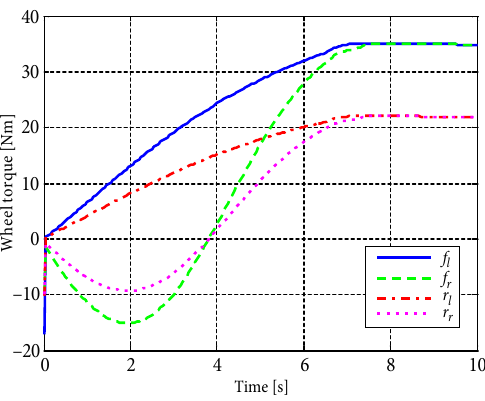
Fig. 15.Wheel torques (right-angle turn case)